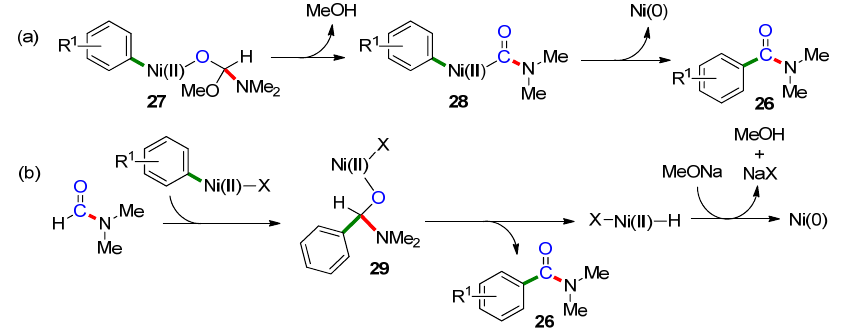
Scheme 11. Simplified proposed reaction mechanism for the Ni-catalyzed aminocarbonylation of aryl iodides/bromides 25 , using DMF as the source of CO and N , N -dimethylamino groups, reported in 2007 by Lee and co-workers [37].